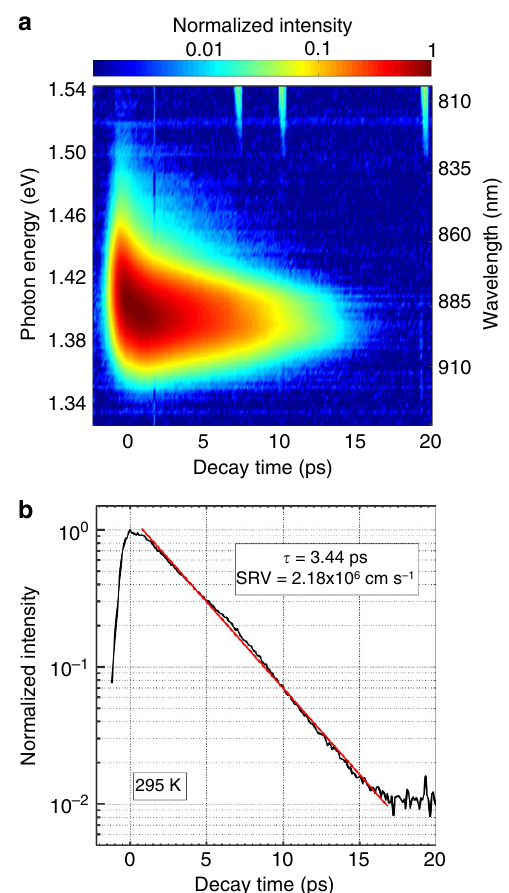
Figure 2 | Measurement of carrier lifetime by PL